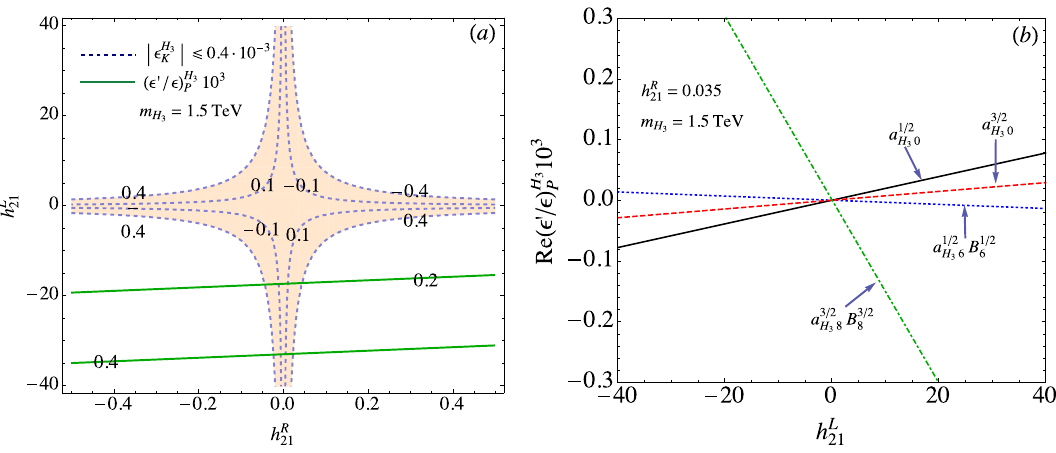
H 3 (in units of 10 (cid:0) 3 ) as a function of h L 0 =(cid:15) ) P 3 . (b) Each contribution of a 1 = 2 (cid:0) = 0 : 21